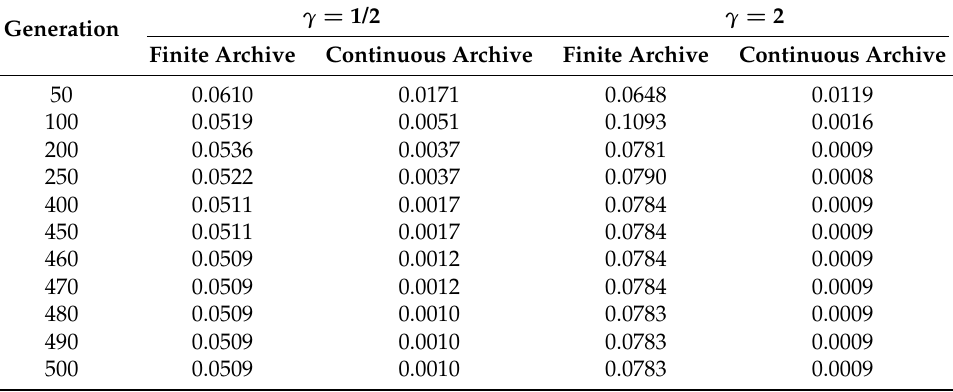
Table 5. ∆ p , q values for the Pareto front approximations for MOP (12) using the MOEA/D archives and with p = 1, q = −